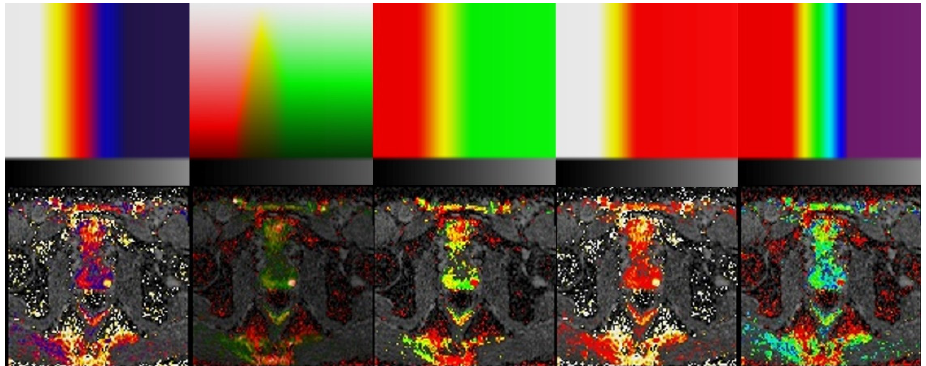
Figure 6. Example of different potential color maps. The map is shown in the top row and the corresponding image in the bottom row. The map is divided into two sections. The high DWI values are color-coded with different maps to better visualize the tumor (left posterior peripheral zone). The low DWI values represent the background (‘no-tumor zone’) and contain a vertical grayscale gradient. It can be noted that the highest ADC value is not white but 50% gray. This darkens the background.